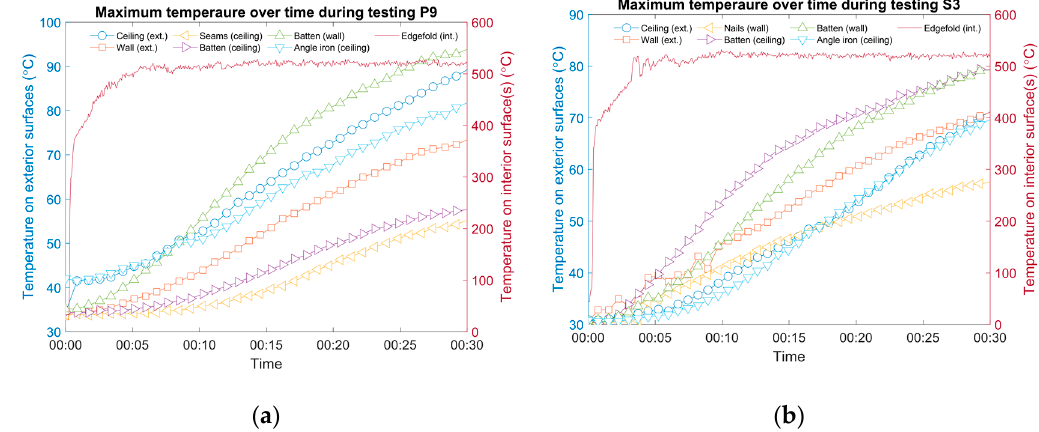
Figure 7. Examples of cases where surface temperatures opposed to fasteners were higher compared to the angle iron and monitoring grid: ( a ) case P9, specimen 3 and ( b ) case S3, specimen 5.